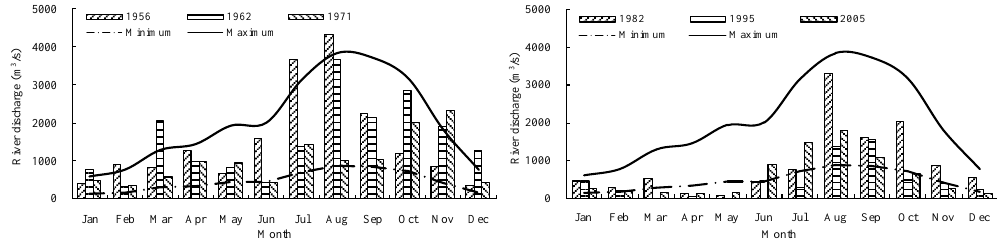
Fig. 6. Monthly river discharge during a typical year and the associated environmental flow boundary in the Yellow River